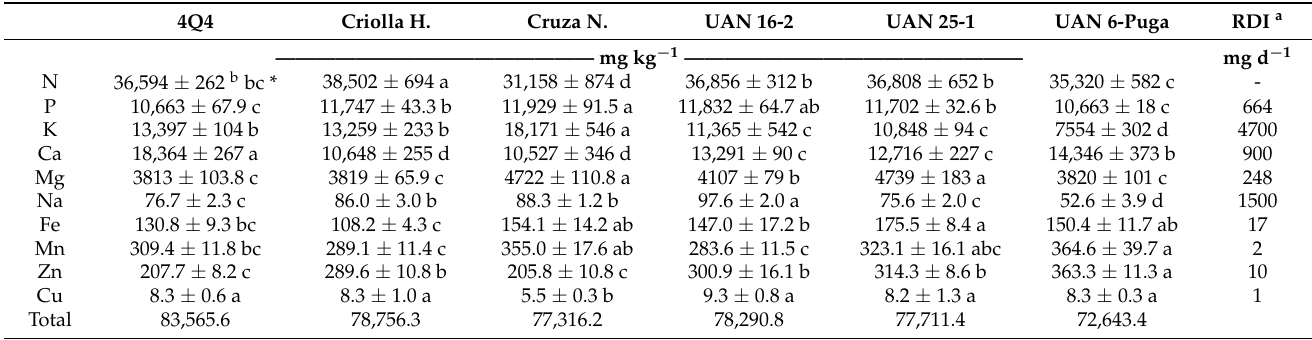
Table 5. Mineral content (dry basis) of leaves from different roselle